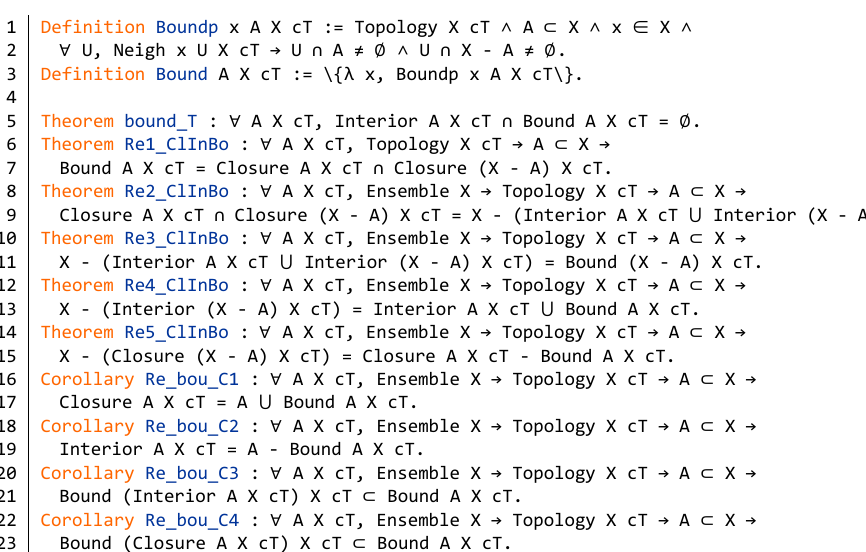
Figure 2. The formalization of definitions and classical properties for